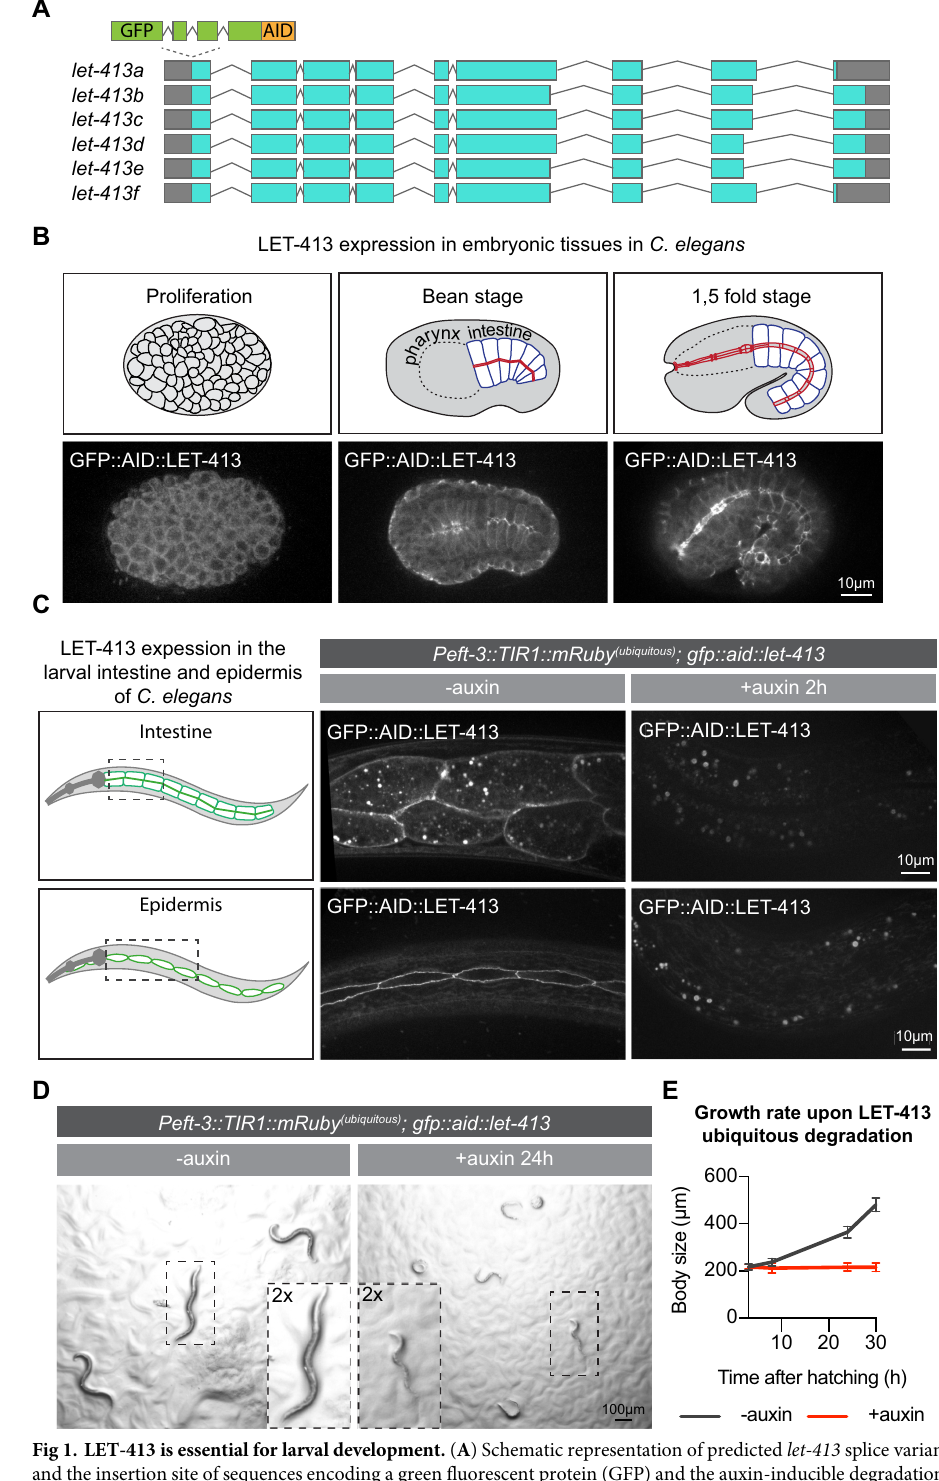
Fig 1. LET-413 is essential for larval development. ( A ) Schematic representation of predicted let-413 splice variants and the insertion site of sequences encoding a green fluorescent protein (GFP) and the auxin-inducible degradation degron (AID). ( B ) Expression of LET-413 in embryonic development (strain BOX466). ( C ) Expression of LET-413 in the intestine and epidermis of Peft-3 :: TIR1 :: mRuby; GFP :: AID :: let-413 L4 animals in the absence (-auxin) or presence (+auxin) of auxin for 2 h (strain BOX469). Drawings are a schematic representation of the LET-413 expression